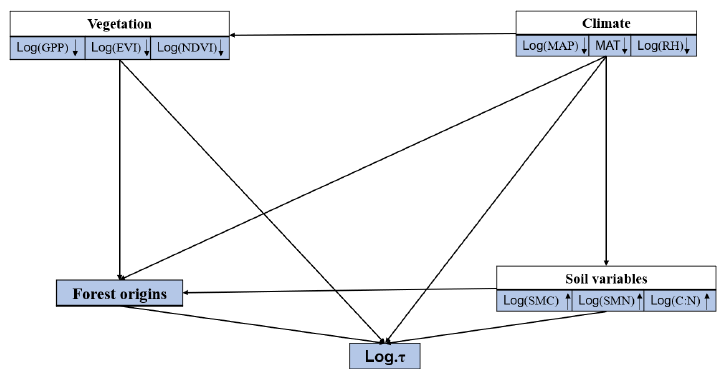
Figure A3. A conceptual model of the overall effects of environmental variables on τ. Climate variables include MAT, MAP, and RH. Vegetation variables include NDVI, GPP, and EVI. Soil variables include SMC, C:N, and SMN. The symbols “ ↑ ” and “ ↓ ” indicate a positive or negative correlation between environmental factors and subsoil τ.